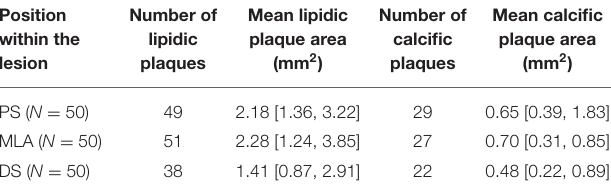
TABLE 4 | Plaque composition and microfeatures.